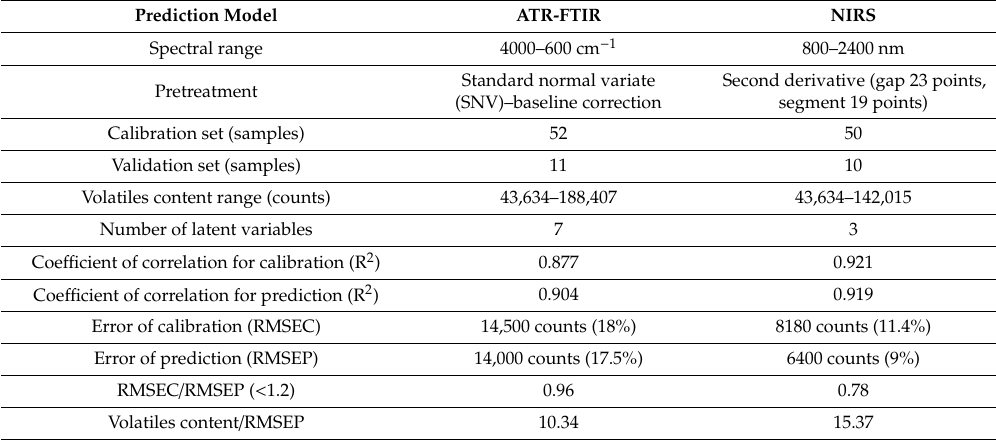
Table 1. Summary of ATR-FTIR and near-infrared (NIR) prediction models used to detect volatiles content in infant milk formula: models’ parameters, number of samples, and